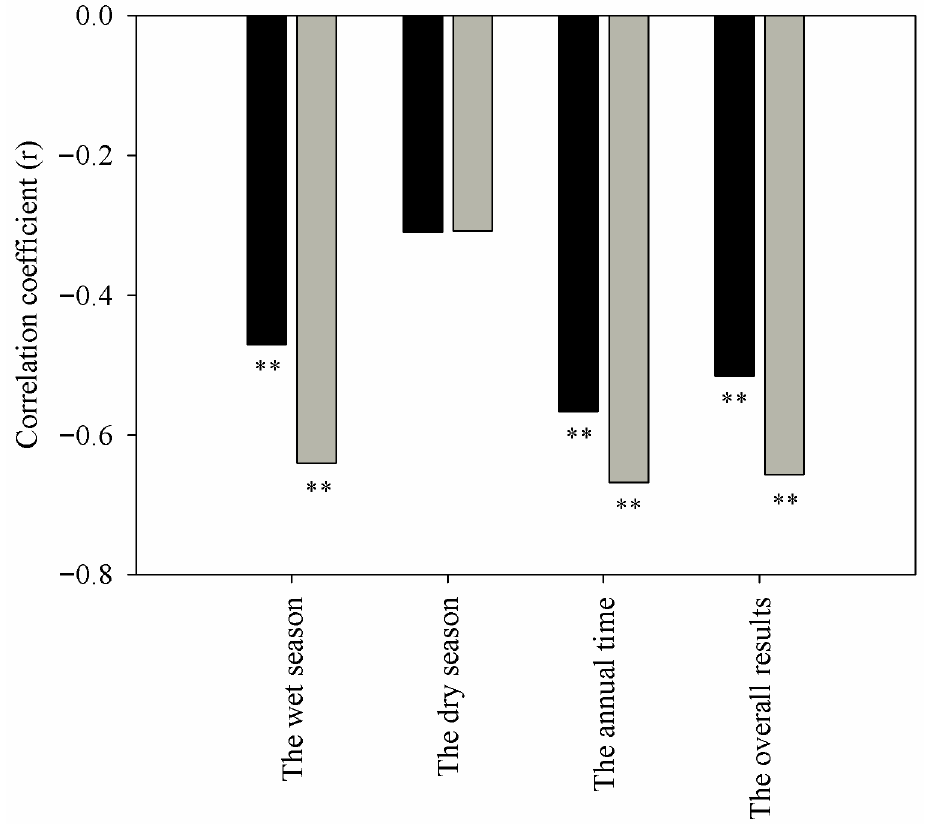
Figure 12. Correlation between the absolute errors for the statistics and ranking scores of the GCMs. Absolute errors for the statistics were between precipitation of the observation and precipitation of the GCM simulations. The black bar represents the Z; the gray bar represents Sen’s slope; ** represents that the correlation was significant at the 0.01 level.